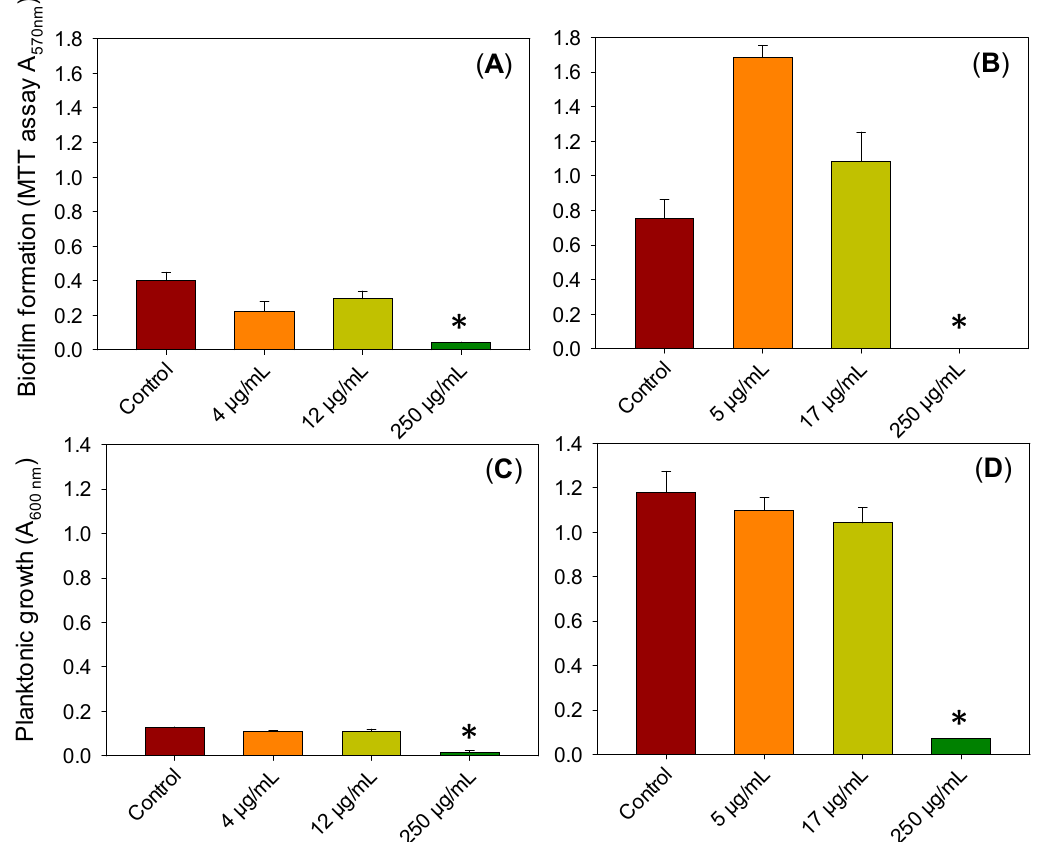
Figure 7. Growth of Pseudomonas aeruginosa ( A , C ) and Staphylococcus aureus ( B , D ) biofilm on the surface of glass coverslips measured with the MTT assay ( A , B ) and in the culture medium surrounding the coverslips ( C , D ), to which resveratrol at different concentrations was added. * indicates a statistically significant difference with respect to the control without resveratrol ( p < 0.05).